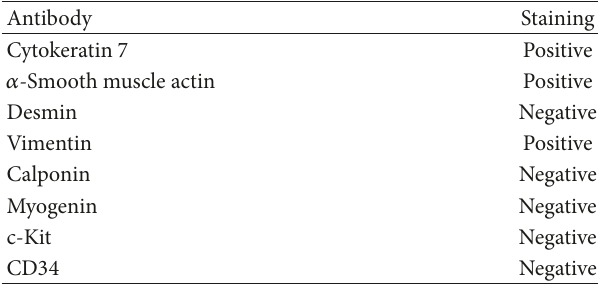
Table 1: Summaryof immunohistochemical outcomes inthe